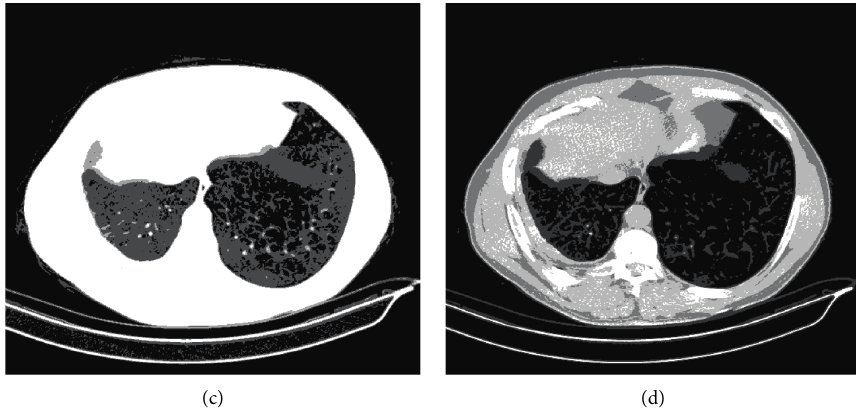
Figure 3: CT image-2 segmentation results of three threshold levels using the proposed approach. (a) Original CT image, (b) level-2 threshold segmentation, (c) level-3 threshold segmentation, and (d) level-4 threshold segmentation.